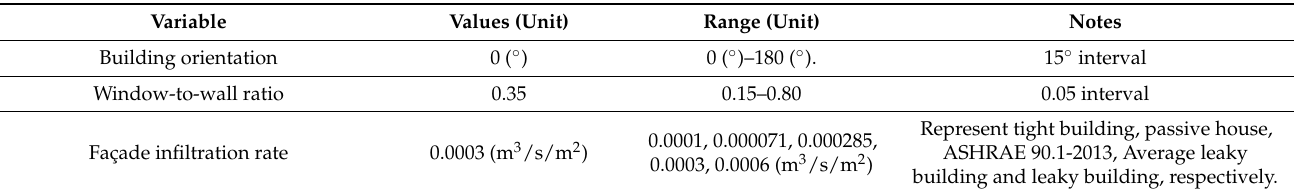
Table 1. Variable for the two-staged optimizations